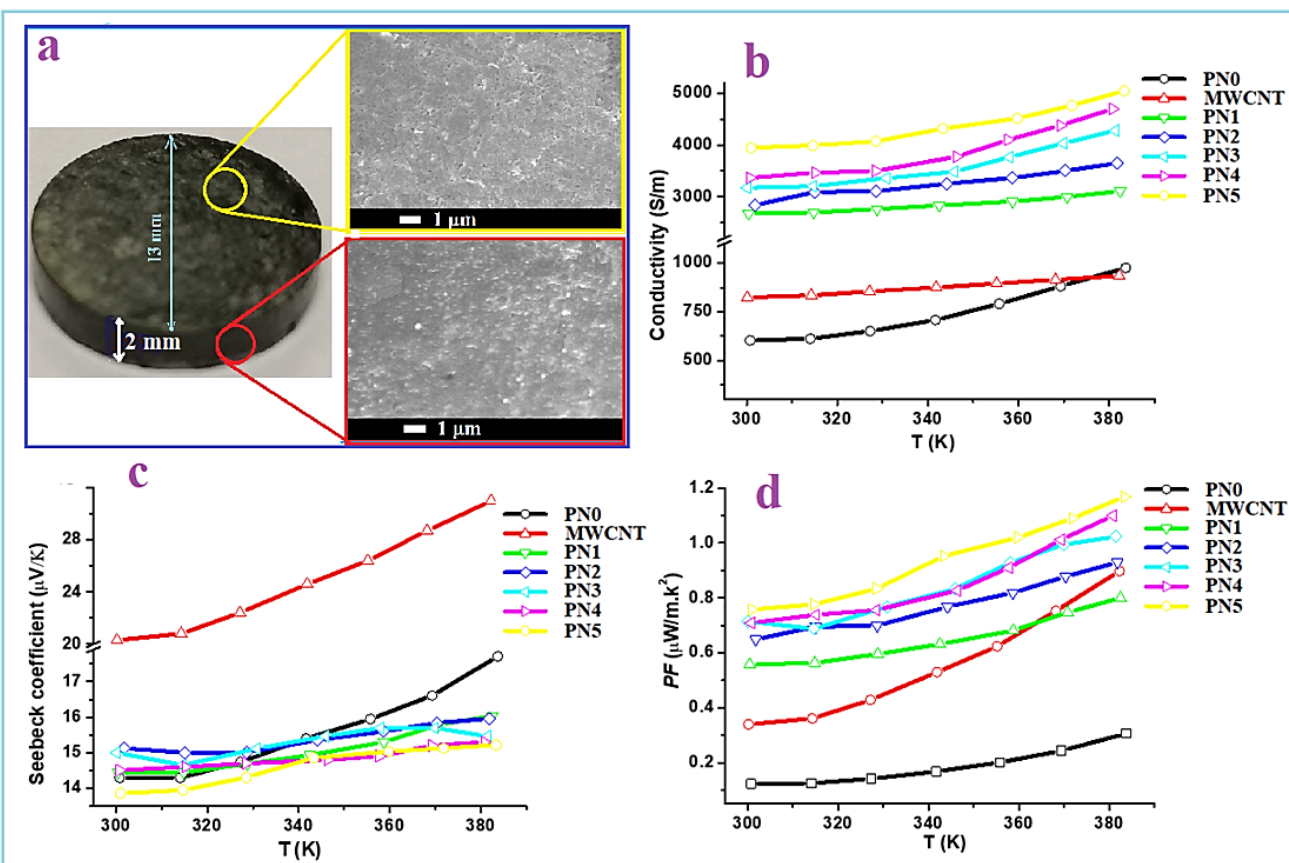
Figure 9. ( a ) Picture of a typical MWCNT/PPy pellet (PN3) along with its SEM top and cross section views. ( b – d ) Thermoelectric (TE) performance of the PPy/MWCNT nanocomposites as the functions of temperature.